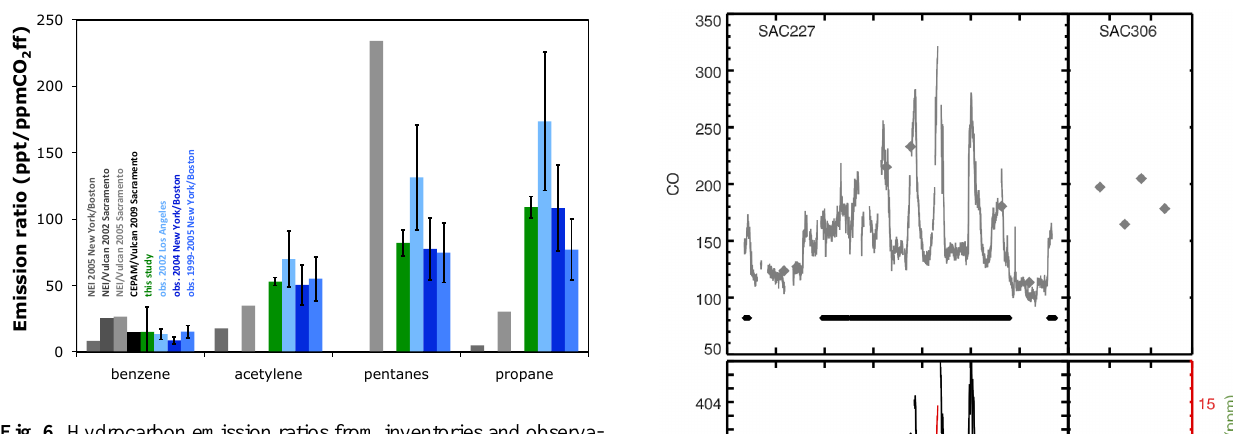
Fig. 6. Hydrocarbon emission ratios from inventories and observa- tions. For each species, up to four inventory estimates are shown in grays, and are (from left to right): New York/Boston NEI 1999 inventory, Sacramento NEI/Vulcan 2002 inventory, Sacramento NEI/Vulcan 2005 inventory, Sacramento CEPAM/Vulcan 2009 in- ventory. Observation-based estimates from this study are shown in green. Three blue bars are (from left to right) observations from Los Angeles in 2002, Boston/New York in 2004 (Warneke et al., 2007), and Boston/New York in 1993–2005 (Baker et al., 2008).